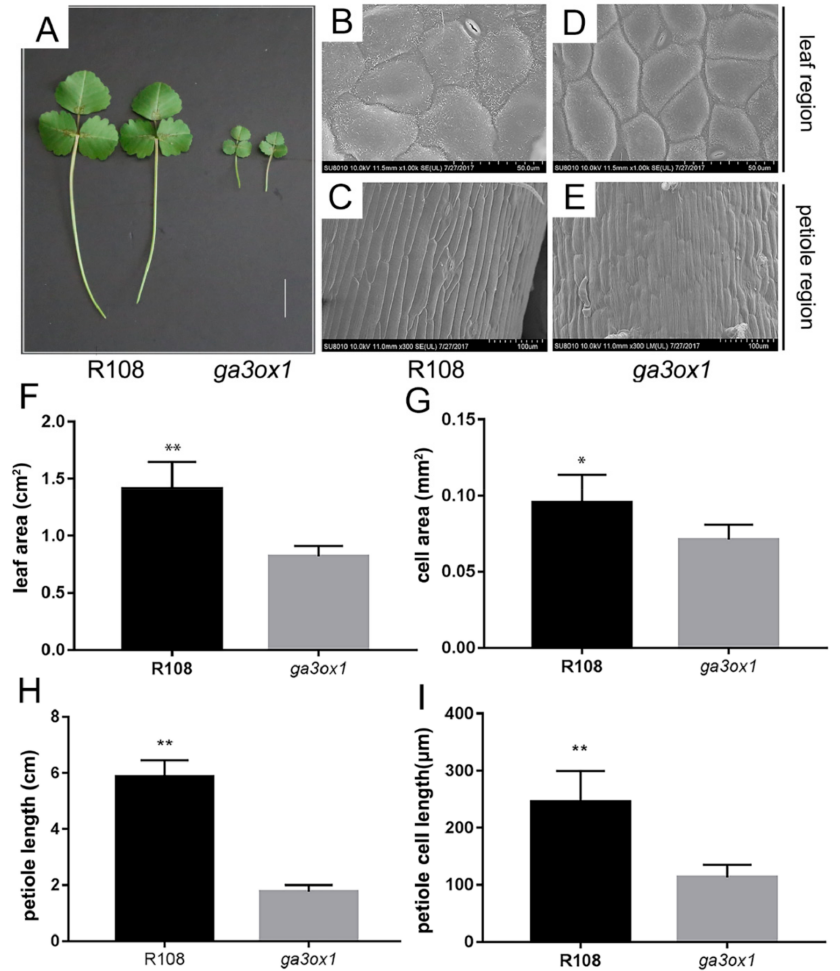
Figure 2. Phenotype identification and analysis of the ga3ox1 mutant. ( A ) Phenotype of ga3ox1 mutant leaves, petioles. Bar = 2 cm. ( B – E ) SEM images of leaves with a magnification of 1000 × and petioles with a magnification of 300 × of wild-type R108 and ga3ox1 mutants, respectively. ( F ) Leaf area of wild-type R108 and ga3ox1 mutants were measured with a leaf area meter. Six single leaves were randomly selected to calculate the cell area. ( G ) Leaf cell area of wild-type R108 and ga3ox1 mutant calculated using the ImageJ software (https://imagej.nih.gov/ij/ accessed on 26 July 2021) [36]. Ten single cells were randomly selected to calculate the leaf area. ( H ) Petiole length of wild-type R108 and ga3ox1 mutant was measured with a ruler. Six single petioles were randomly selected to calculate the petiole length. ( I ) Petiole cell length of wild-type R108 and ga3ox1 mutant calculate using the ImageJ software (https://imagej.nih.gov/ij/ accessed on 26 July 2021) [36], respectively. Ten single cells were randomly selected to calculate the petiole cell length. Error bars indicate SD. * p < 0.05, and ** p < 0.01 by Duncan